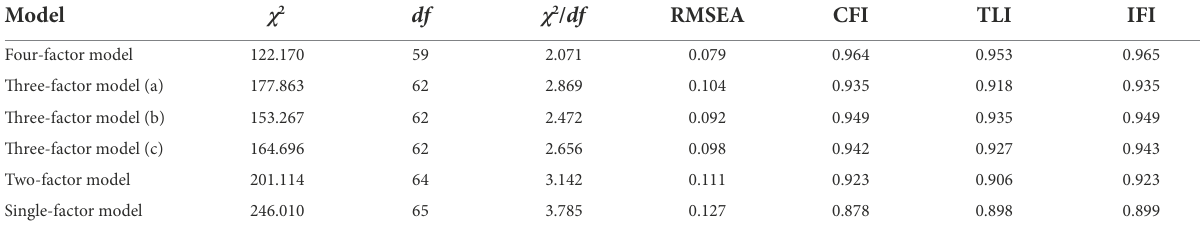
TABLE 1 Confirmatory factor analysis